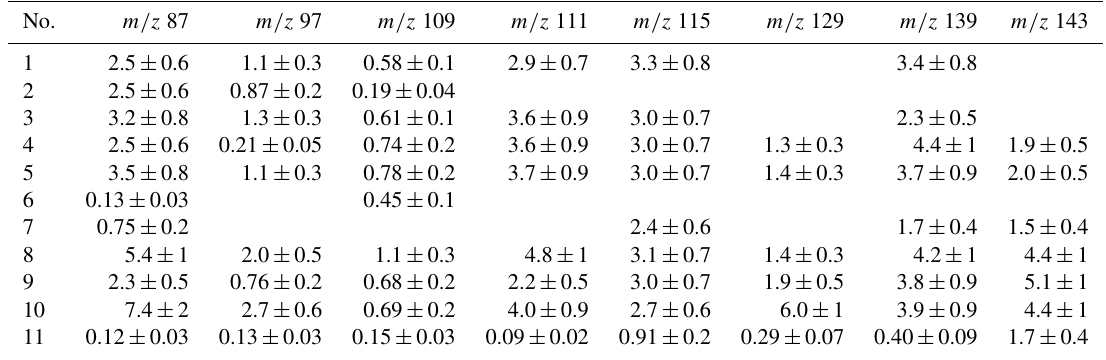
Table 4. Minor gas-phase molar yields (%) for α -phellandrene ozonolysis. No. m/z 87 m/z 97 m/z 109 m/z